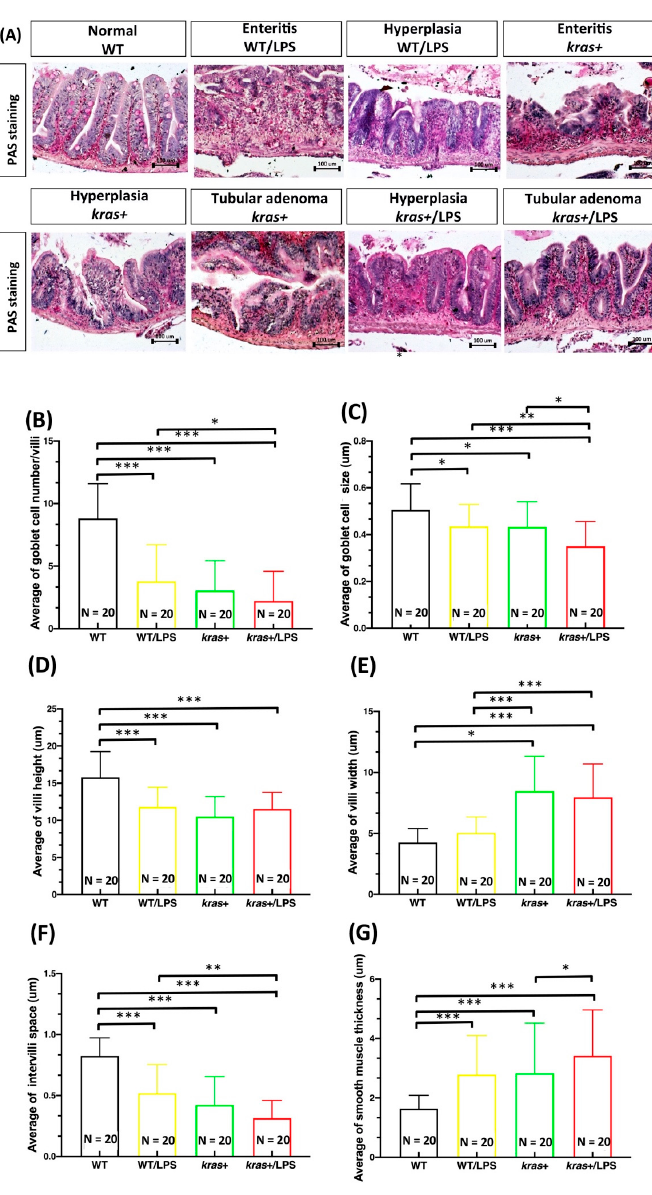
Figure 3. Expression of kras V 12 decreased goblet cell number, goblet cell size, villi height, and intervilli space and increased villi width and smooth muscle thickness in the intestine. At 4 mpf, WT and kras+ zebrafish were treated with 2 µ M of mifepristone and 40 ng/mL of LPS for 4 weeks, and samples were then collected for gross observations and histological analysis. There were four experimental groups: WT, WT/LPS, kras+, and kras+/LPS (WT, N = 20; WT/LPS, N = 20; kras+, N = 20; kras+/LPS, N = 20). ( A ) PAS staining was carried out in intestinal sections. ( B – G ) Quantification of goblet cell number, goblet cell size of villi, villi height, intervilli space, villi width, and smooth muscle thickness in the intestine. Differences among the variables were assessed using Student’s t-tests. Statistical significance: * p < 0.05, ** p < 0.01, *** p < 0.001. Scale bar: 100 µ